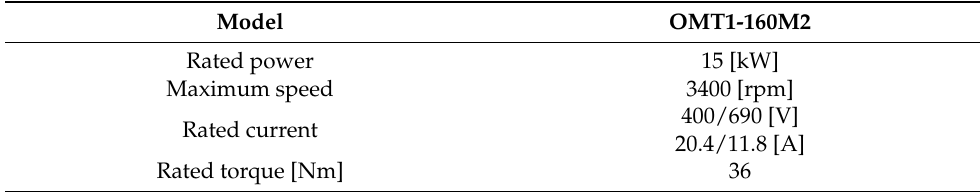
Table 2. Asynchronous motor